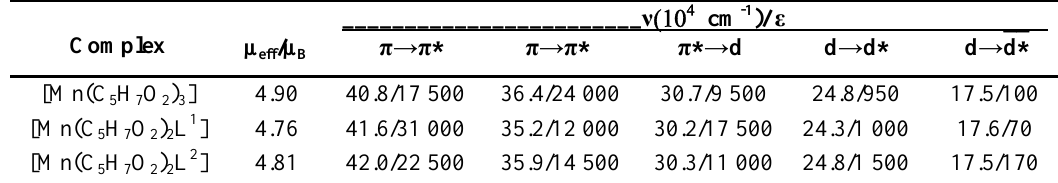
Table 3 . The electronic spectral data of the complexes recorded in